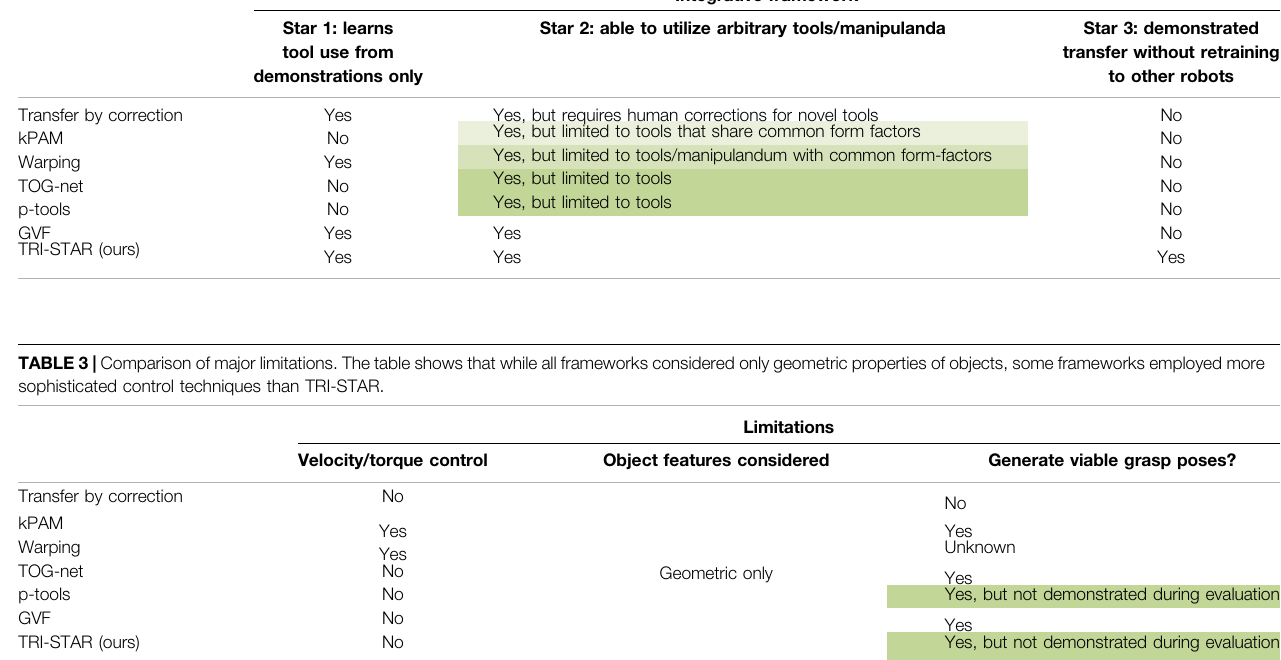
Integrative framework